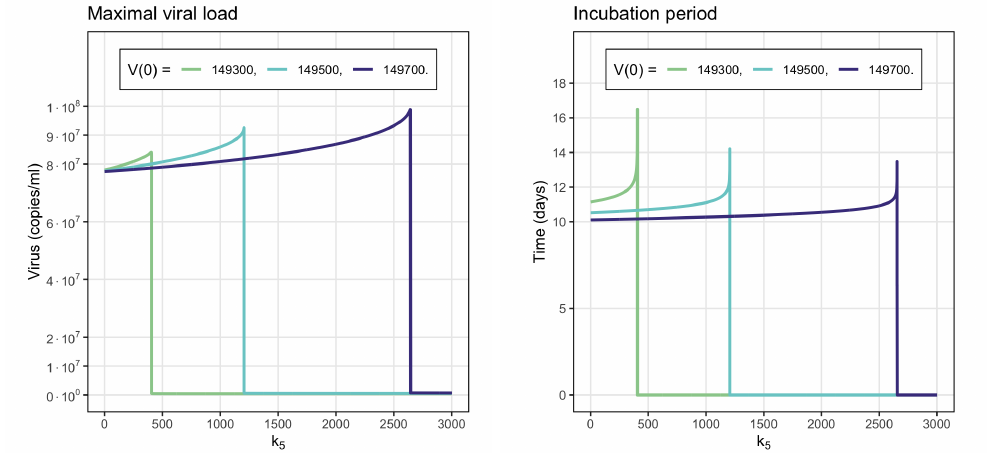
Figure 8. Numerical evaluations of the behavior of the virus depending on the antibodies secretion rate k 5 . The vertical lines are the k 5 values at which the antibodies do not allow the development of viral infection, preventing the appearance of peaks with high virus concentrations. Left : maximal virus load. Right : incubation